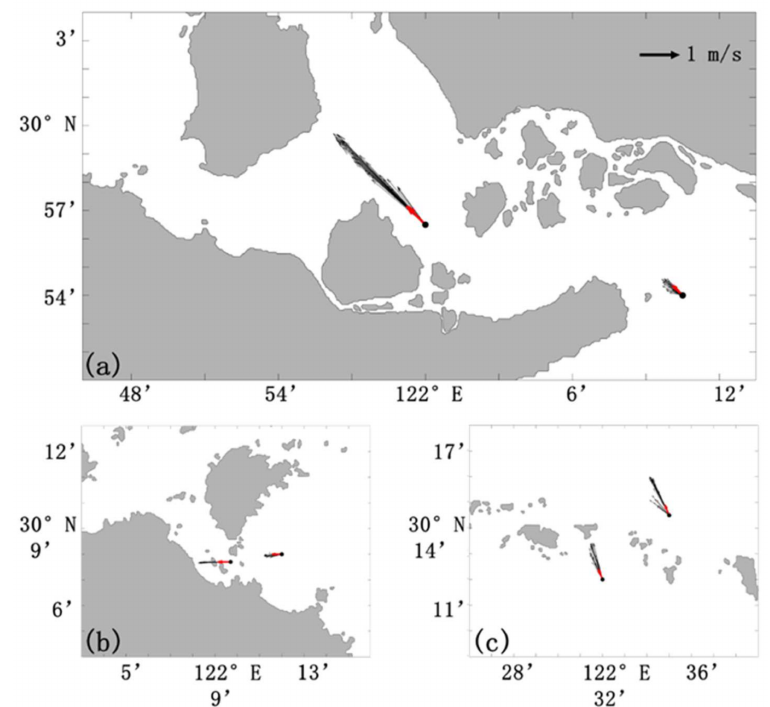
Figure 5. MFDs and tidal currents at the maximum flood at chosen points in ( a ) the Luotou Channel, ( b ) the Guanmen Channel, and ( c ) the Dongji Islands. The red arrows show the MFDs, and the black arrows show the tidal currents over 16 days.